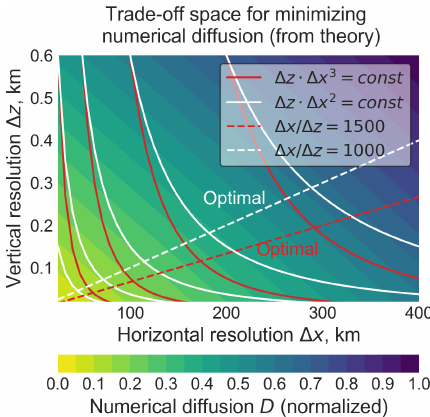
Figure 1. Optimal combination of horizontal and vertical grid res- olutions ( (cid:49)x and (cid:49)z ) for minimizing numerical diffusion of chem- ical plumes within a given amount of computational resources. Re- sults are from the theoretical analysis of Sect. 2.3. The filled con- tours show the magnitude of the numerical diffusion term D from Eq. (23) as a function of (cid:49)x and (cid:49)z with B/A = 500. The solid lines indicate a fixed amount of computational resources ( P ) in the trade-off between horizontal and vertical resolution, either using a fixed time step ( (cid:49)z(cid:49)x 2 = P ) or accounting for the CFL condition ( (cid:49)z(cid:49)x 3 = P ). The dashed lines from Eq. (27) indicate the corre- sponding optimal (cid:49)x /(cid:49)z ratios to minimize numerical